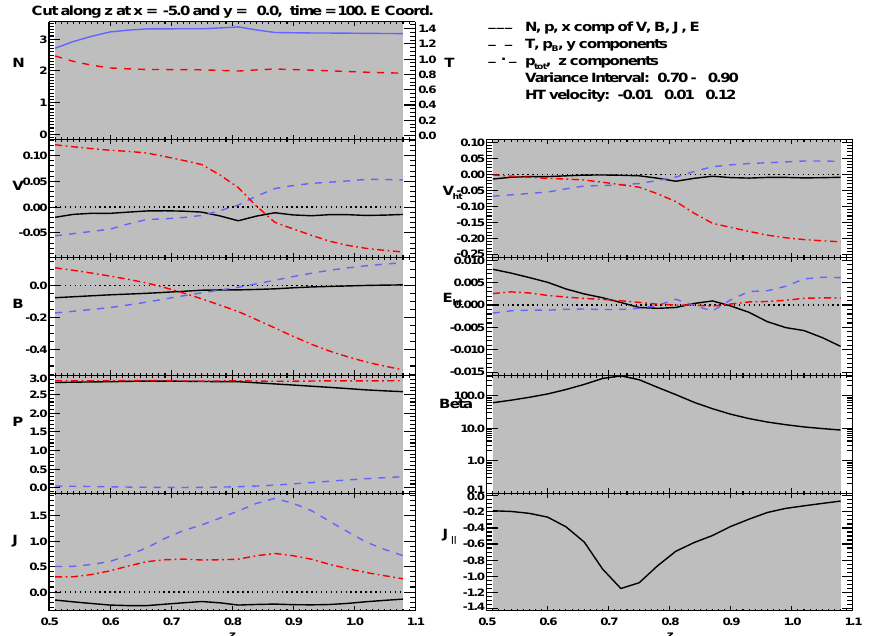
Fig. 8. Simulated “data” for a cut along z at (x,y) = ( 3 , 0 ) transformed into MVAE boundary normal coordinates for outer CDC/magnetosheath boundary. All quantities are plotted in normalized simulation units. Plotted in the left column from top to bottom are the density (solid blue line) and temperature (dashed red line), velocity components (x – solid black, y – dashed blue, z – dash-dot red), magnetic field components, pressure (thermal pressure – black, magnetic pressure - blue, total pressure – red), and current density components. The right column displays the velocity and electric field components in the deHoffman-Teller frame, plasma β , and the parallel current